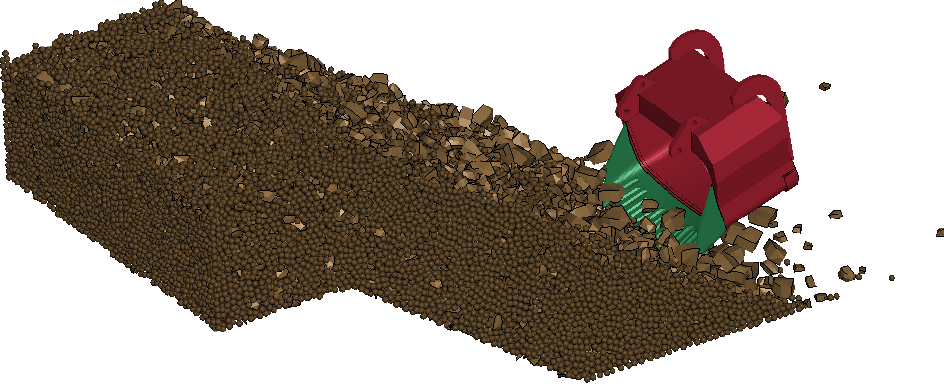
Figure 7. Numerical model setup including the rigid body bucket and the granular material.